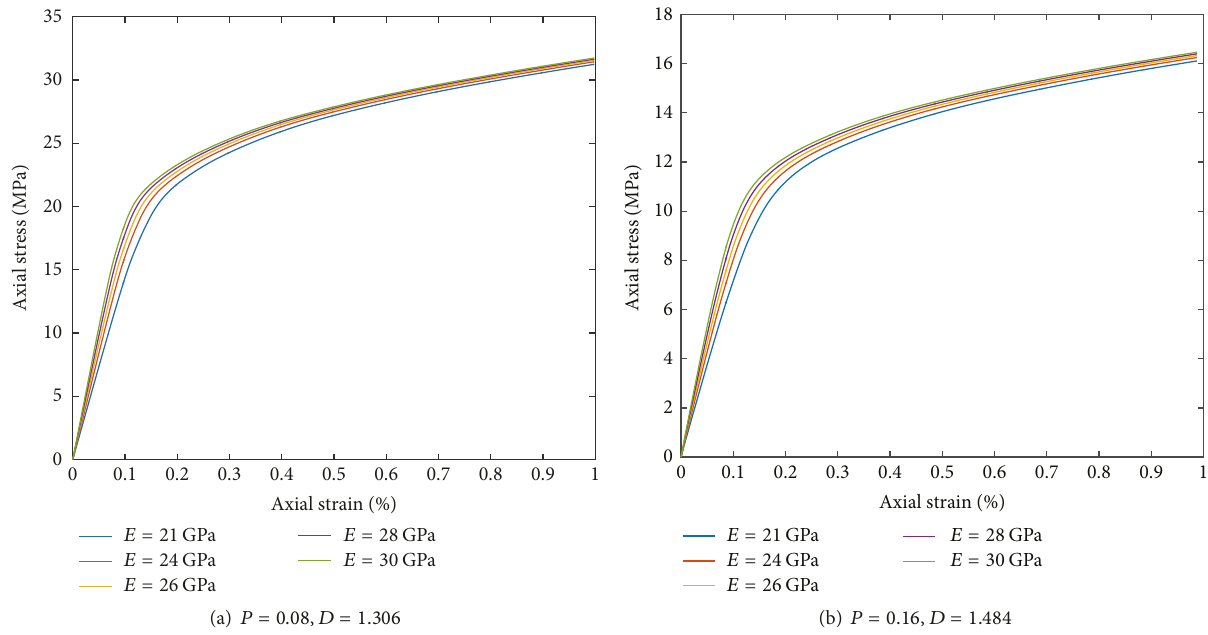
Figure 8: The stress and strain curves with the porosity and fractal dimension consistent with the variation of the elastic modulus of the matrix.